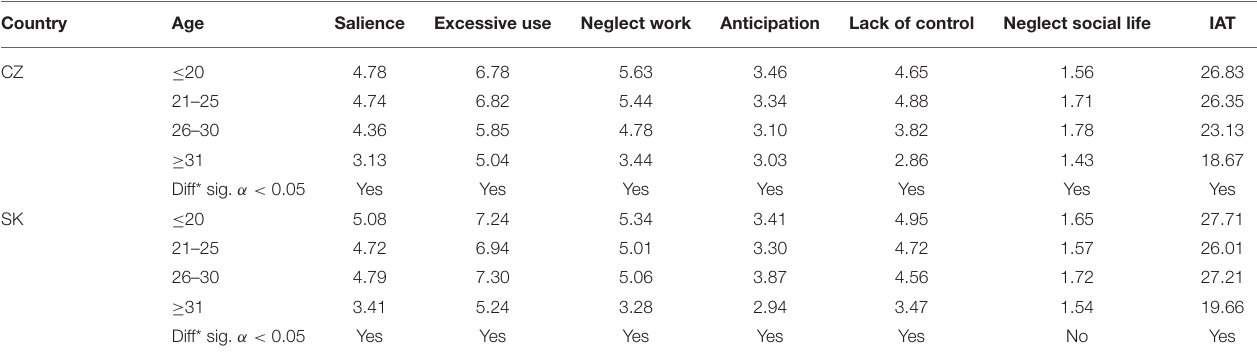
TABLE 4 | Mean values of the IAT and its subscales in the classification by age. Country Age Salience Excessive use Neglect work